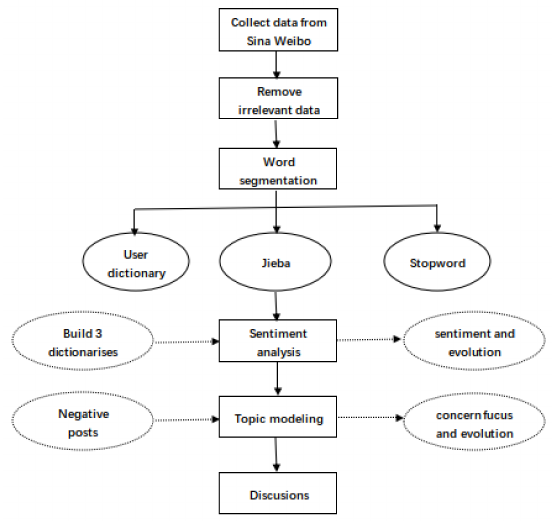
Figure 1. Flow chart of text data